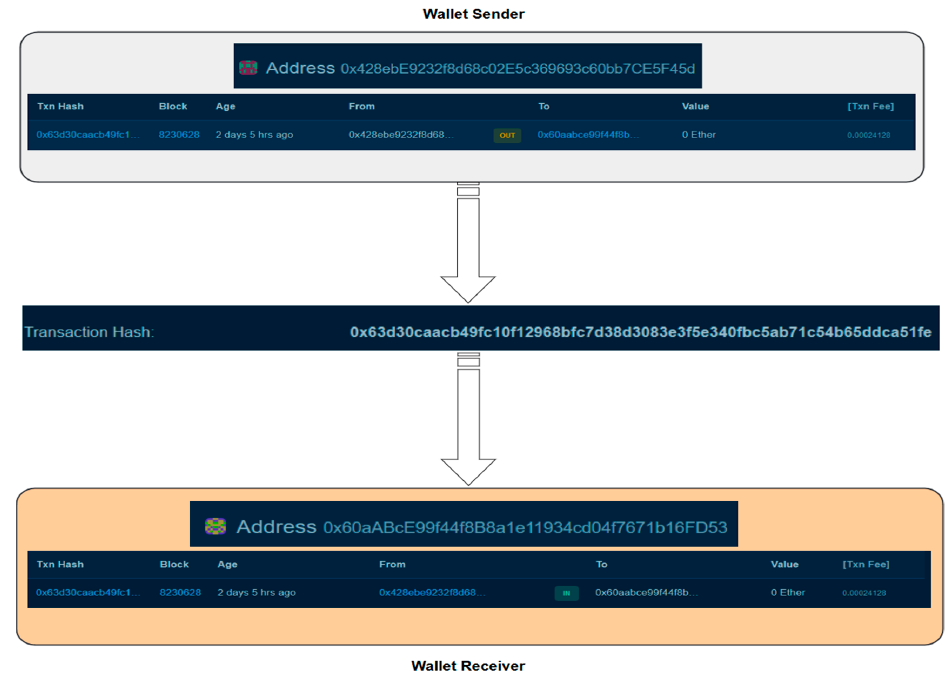
Figure 16. Procedure for the blockchain implementation.